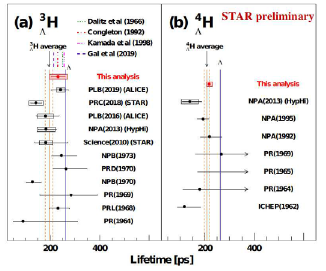
H (a) and 4 H (b) are shown Λ Λ H and Λ